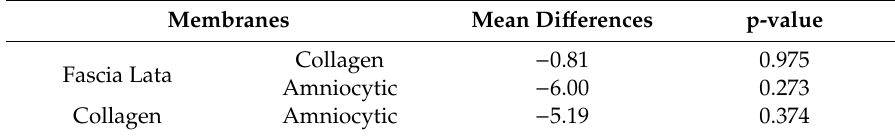
Table 6. Tukey’s HSD test. Based on the means of radiological density percentages observed according to the membrane. The di ff erence between the membranes was not significant.